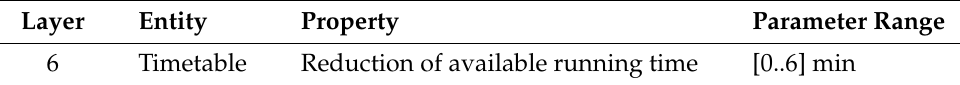
Table 4. Description of the entities and their parameters relevant for testing the influence of dif- ferent timetables on the ATO performance. Only showing relevant definitions differing from the base scenario.